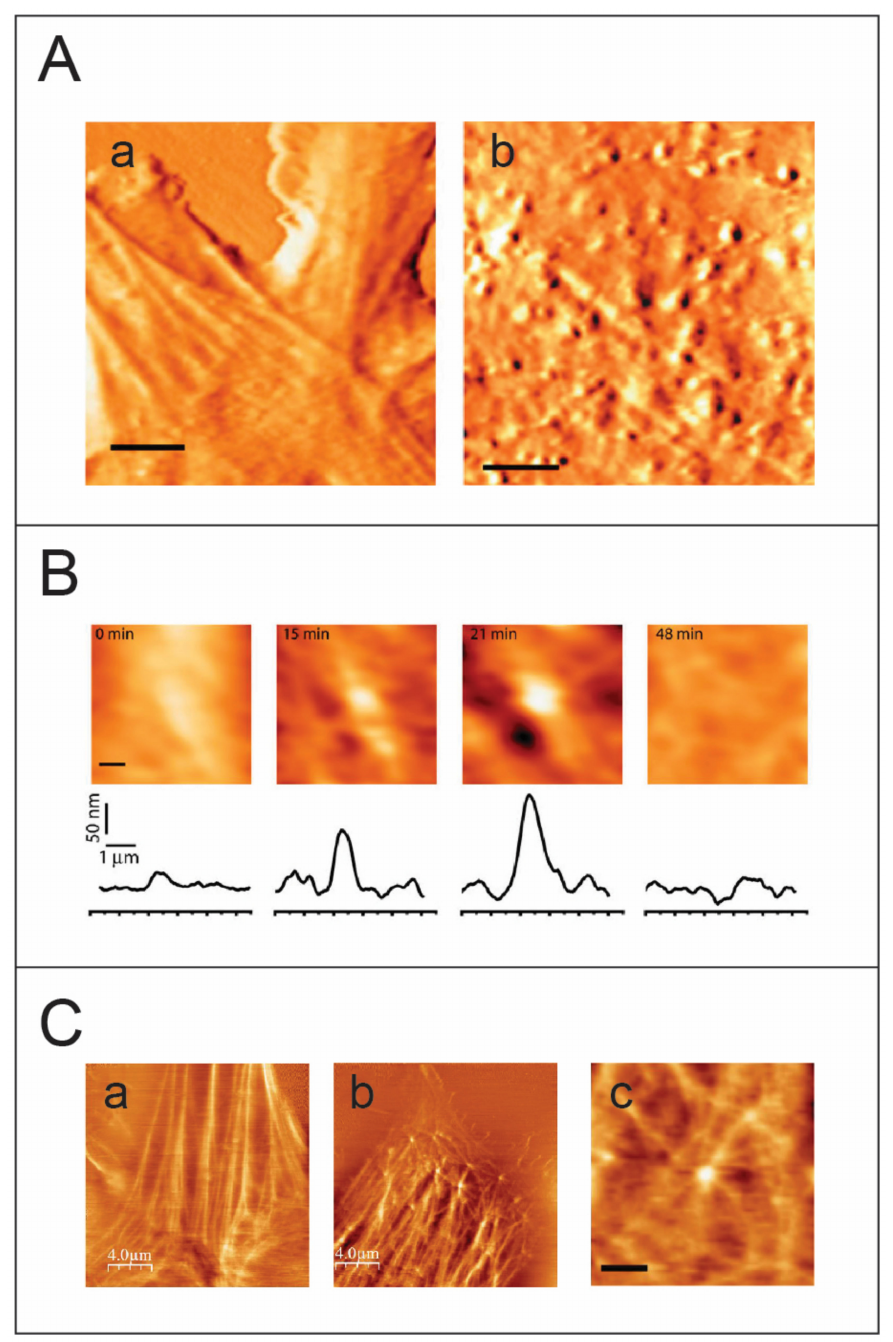
Figure 3. Imaging retrovirus budding from live cells using atomic force microscopy. ( A ) AFM images, acquired in tapping mode, of an ( a ) uninfected and ( b ) HIV-1 infected NIH/3T3 live cell. Virus particles at different stages of budding appear as protrusions of different heights on the cell membrane. Scale bar is 3 µ m. ( B ) Visualizing a complete budding progress from initial assembly to release of a single virus particle. Scale bar is 0.5 µ m. ( C ) Imaging the cytoskeleton of live cells using the AFM in the torsional mode. ( a ) an AFM image of an uninfected live cell. The cytoskeleton fibers are clearly detected beneath the cell membrane. ( b ) An AFM torsion image of an HIV-1 infected cell reveals the fine actin architecture beneath the cell membrane (an enlargement is shown in ( c ), scale bar is 1.5 µ m). The virus particles colocalize to form actin star-like shapes. Panels A and B are taken from [76], while C is taken from